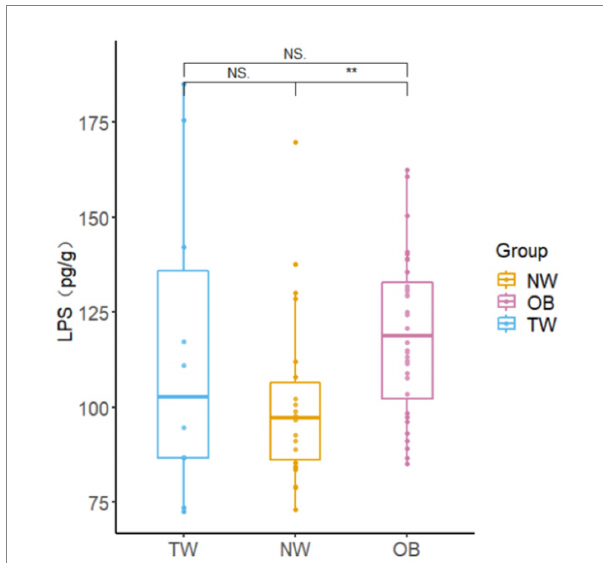
FIGURE 7 Fecal LPS contents in different groups. Box-and-whisker plots represent the median, interquartile range, and minimum and maximum LPS content within each group. Asterisks above the boxes indicate significant differences ( p < 0.05). t -test was used to test for significant differences in statistics. NS p > 0.05, * p ≤ 0.05, and ** p ≤ 0.01.